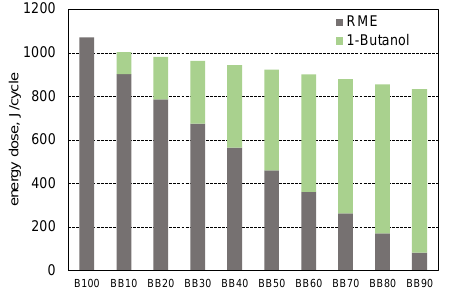
Figure 2. Composition of the fuel energy dose.